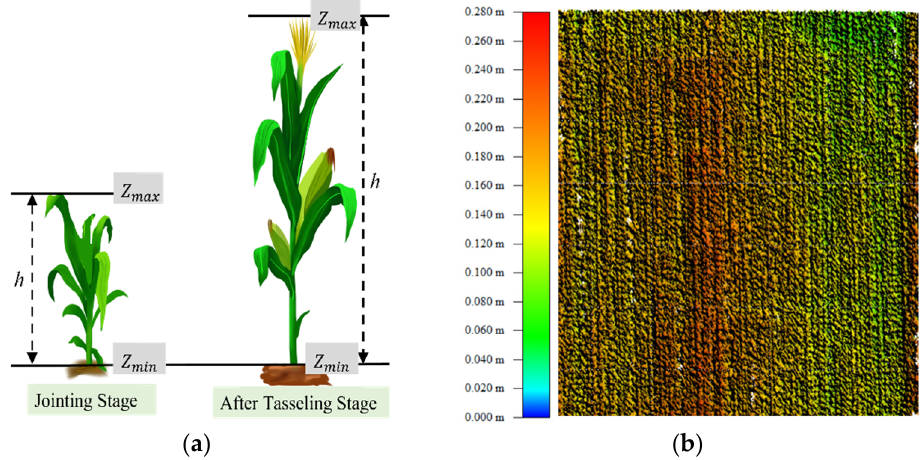
Figure 9. ( a ) Diagram of maize height estimation; ( b ) DTM at the seedling